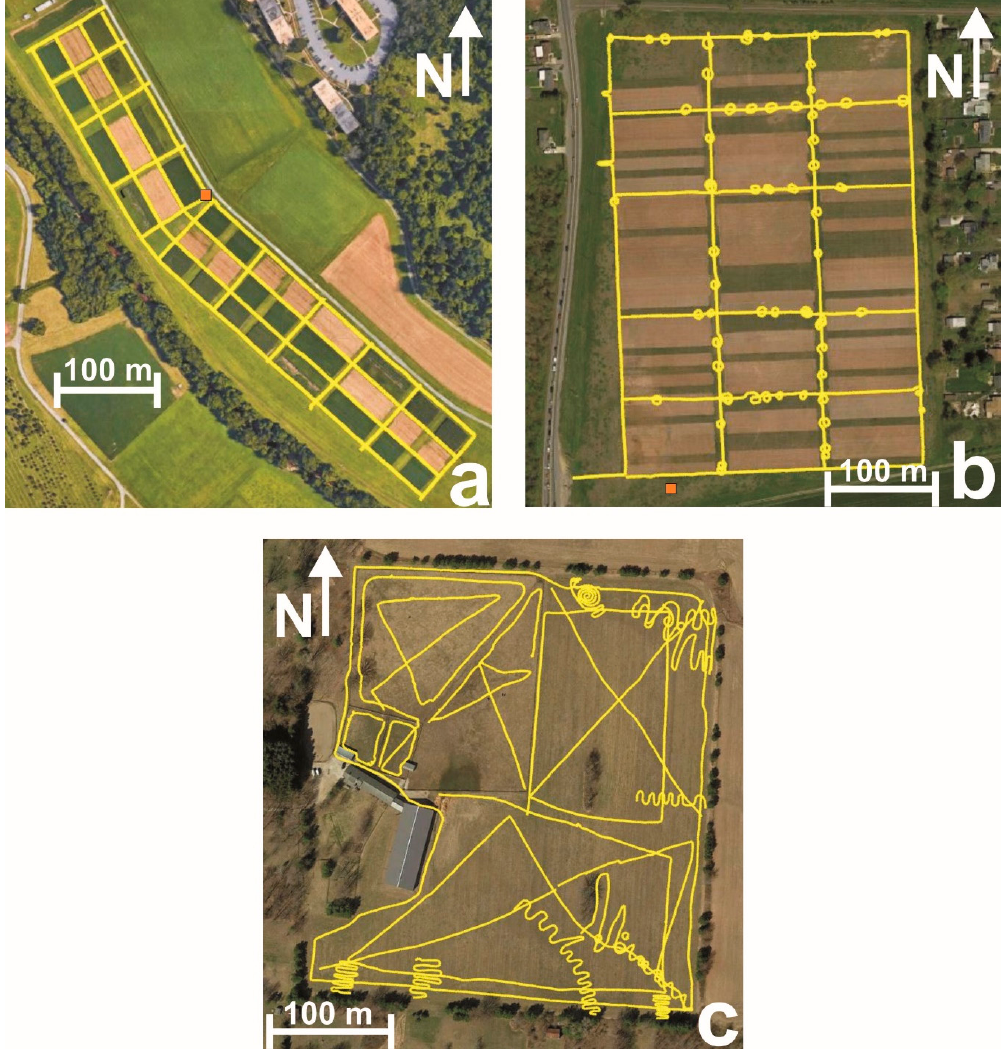
Figure 4. GPR measurement transects (yellow lines) and locations of physical RTK/GNSS base stations (orange squares): ( a ) Site 1; ( b ) Site 2; ( c ) Site 3.